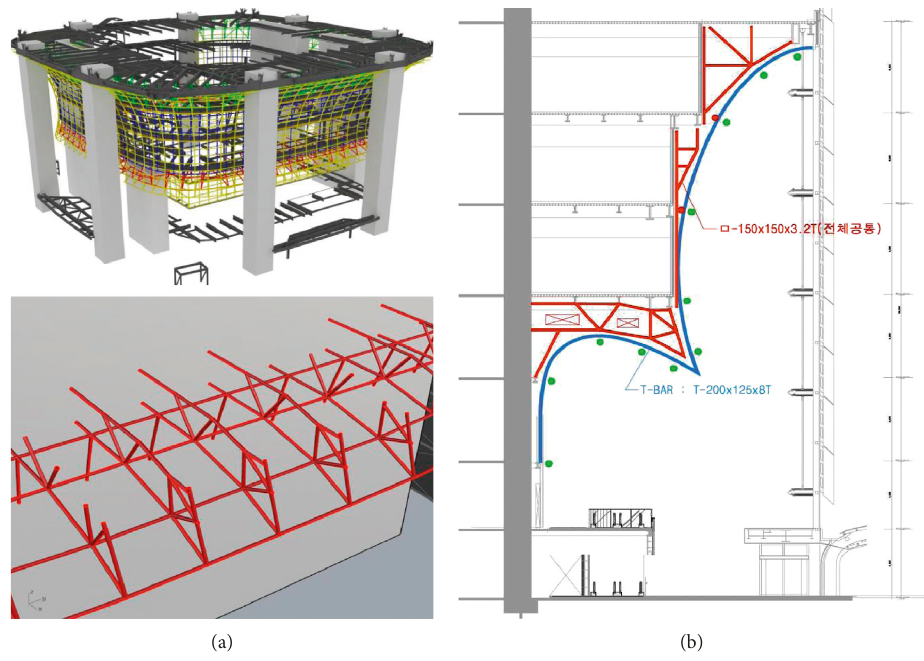
Figure 5: (a) SSS model (green and red). (b) Section view.